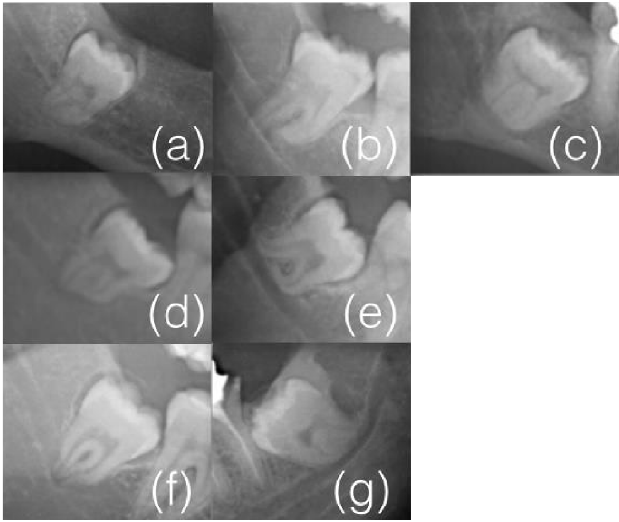
Fig. 1. (a) The different x-ray images that should alert the surgeon. Loss of lamina dura of canal, (b) radiolucent of mesial apex, (c) deviation of the canal, (d) periapical radiolucent area, (e) curvature of roots, (f) narrowing, (g) narrowing of the canal.